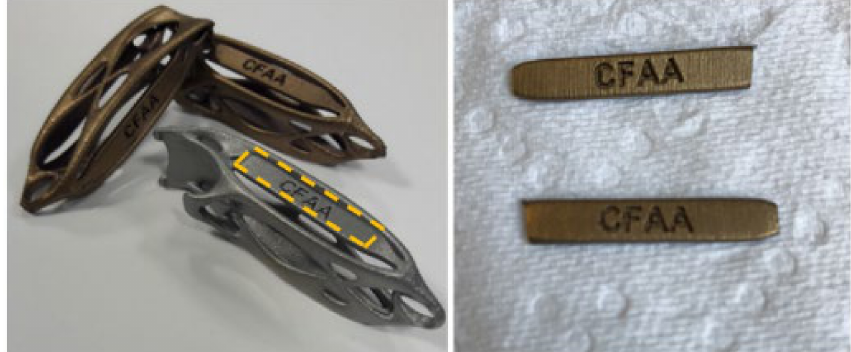
Figure 1. AlTiSiN coated specimens—Set 1.